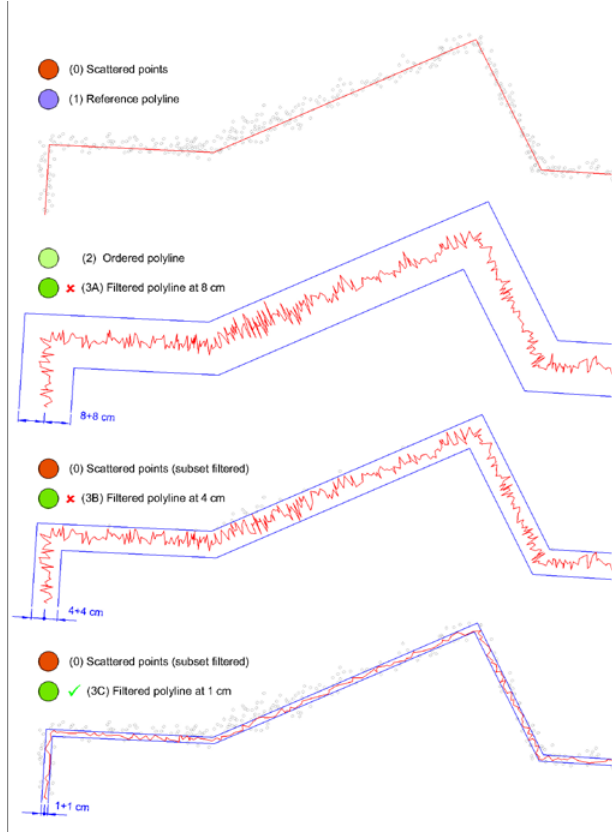
Fig. 3 Anzani, G., View of some of the products related to filtering process obtained by varying the setting parameters ,